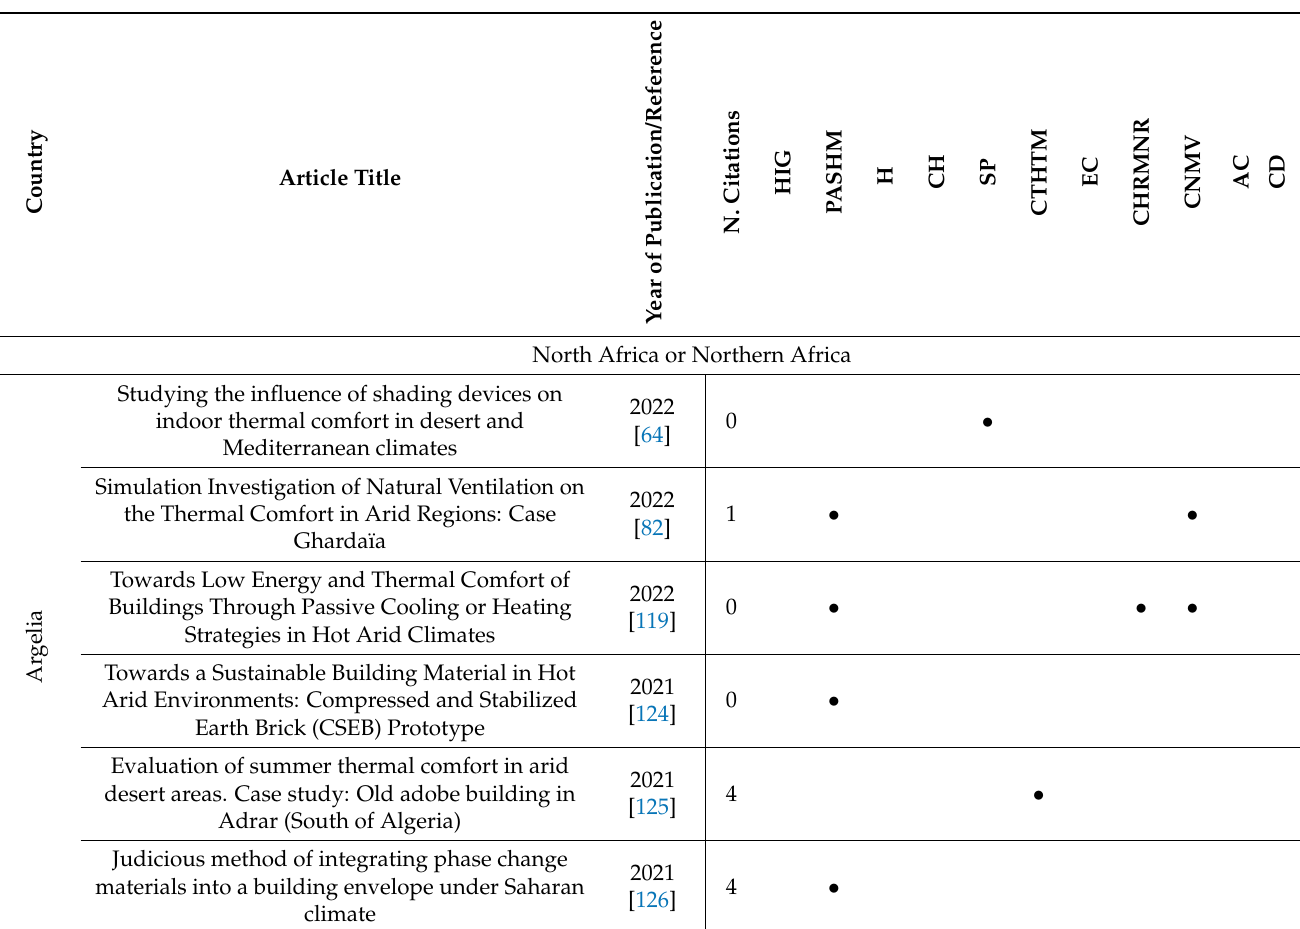
Table A2. Relevant case studies identified by date/year found in SCOPUS and WOS regarding countries in